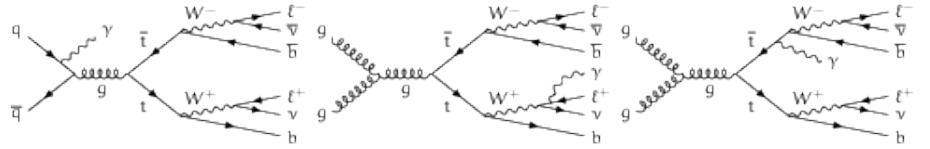
Figure 15. Leading-order Feynman diagram for the t¯tfl process. Each diagram demonstrates a different production mechanism for the high energy photon in the process.